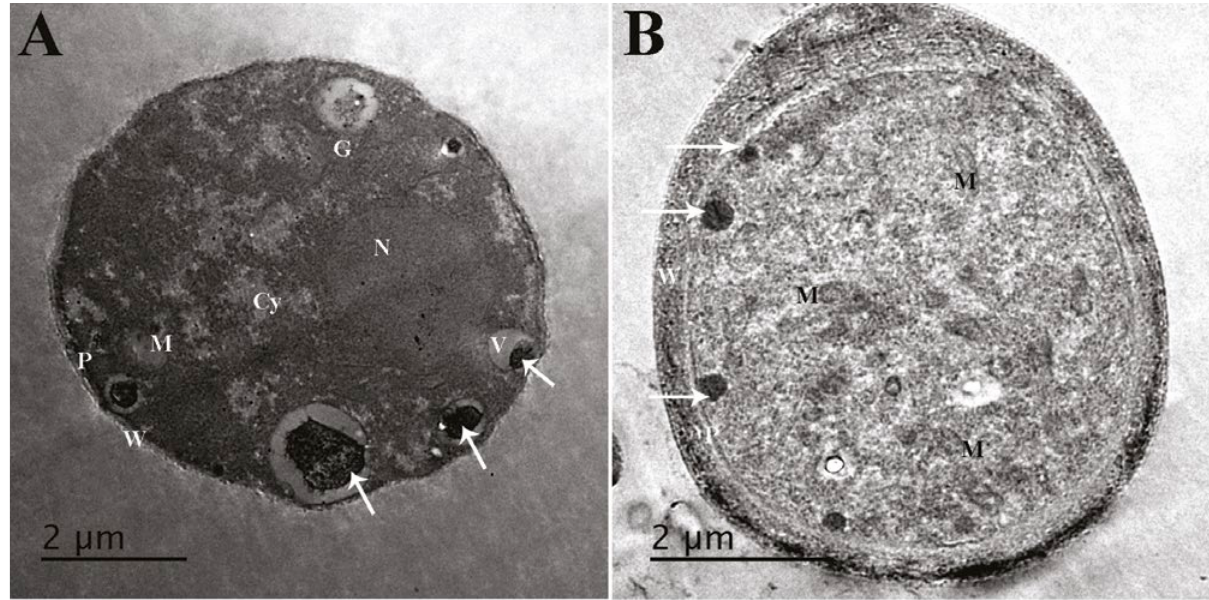
Figure 1. TE micrograph of a transverse sections of Rhizoctonia solani hyphae. A. Untreated (control) showing a thin electron-lucent cell wall (W) with a plasma membrane (P). The cytoplasm (Cy) contains a nucleus (N) and electron-lucent glycogen particles (G). Note electron-dense inclusions (arrows) inside the vacuoles (V). B. Hypha treated with the khella extract (10%), showing a thick electron-dense cell wall (W), plasma membrane (P), numerous mitochondria (M) and elec - tron-dense bodies (arrows). Note the absence of glycogen